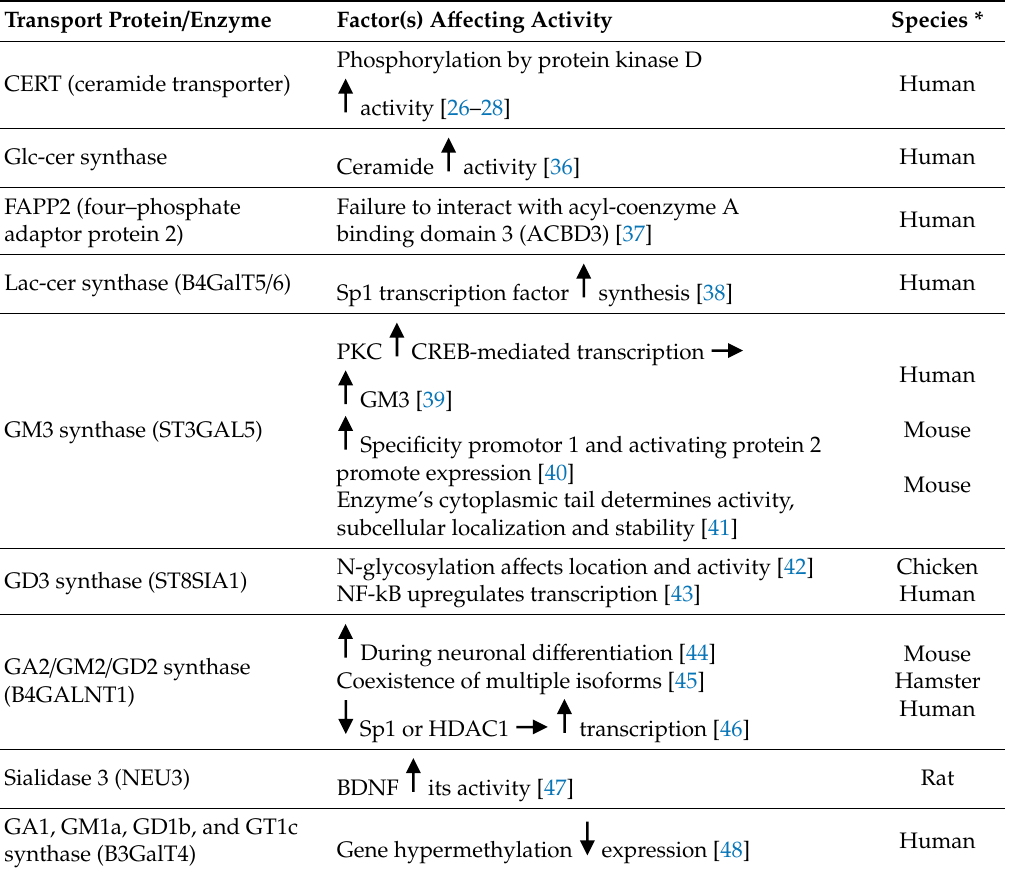
* Animal sources are indicated as results may be species-dependent. Arrows pointing up indicate an increase, arrows pointing down, a decrease.